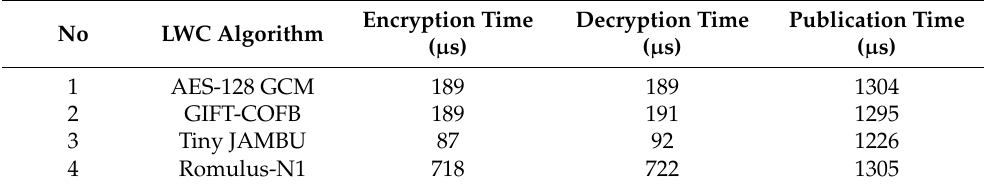
Table 11. Lightweight Cryptographic Encryption and Decryption Performance on STM32L4 with 20 Characters Messages Used Anonymous Account.